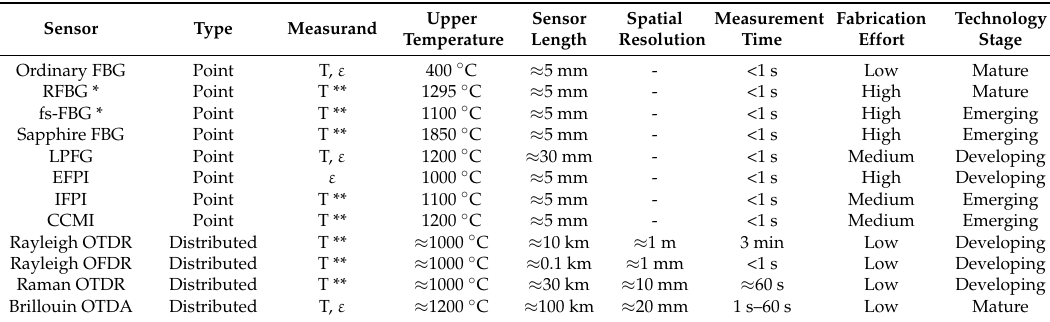
Table 1. Summary of high temperature fiber optic